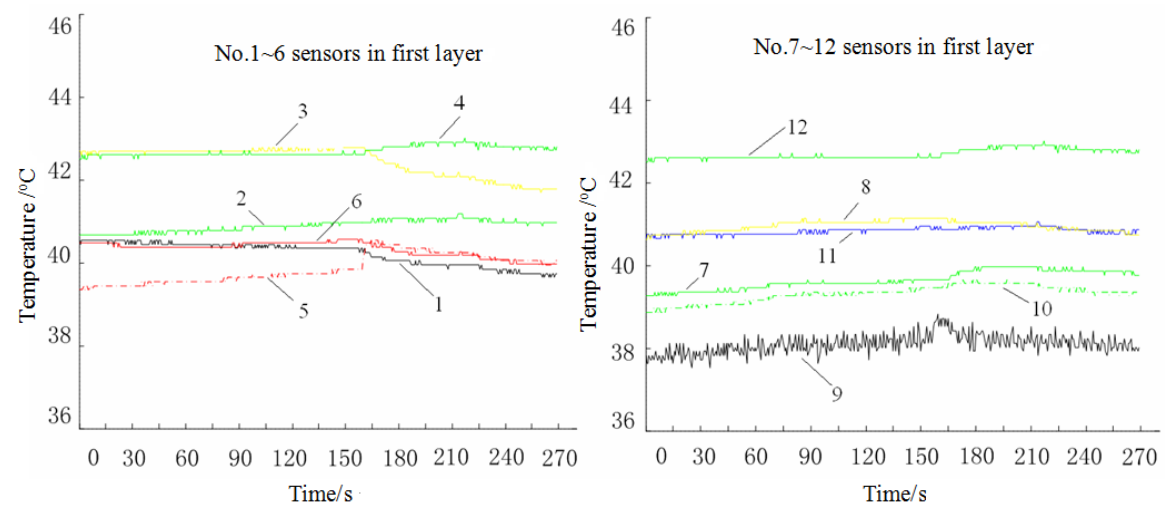
Figure 6. Temperature measurement in the first